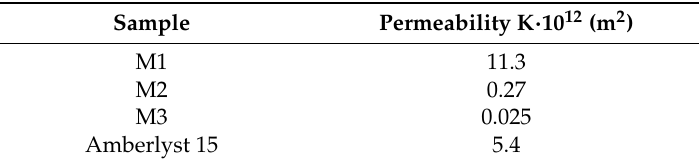
Table 2. Permeability of silica monoliths and Amberlyst 15.